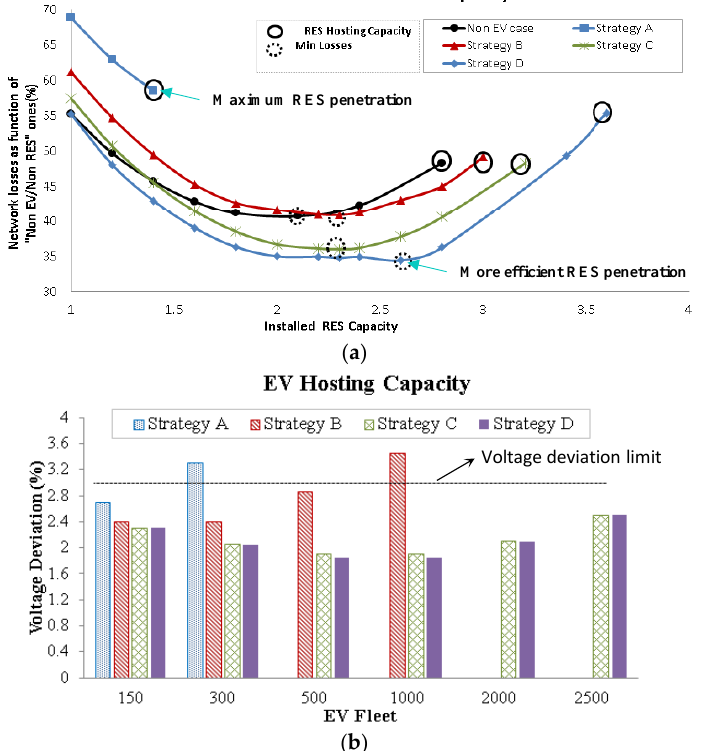
Figure 10. ( a ) Network losses for various cases of RES penetration when considering the introduction of 300 EVs in the island of Ikaria; ( b ) voltage deviation for various levels of EV penetration when considering that 2.1 MW RESs are installed in the island of Ikaria [37].